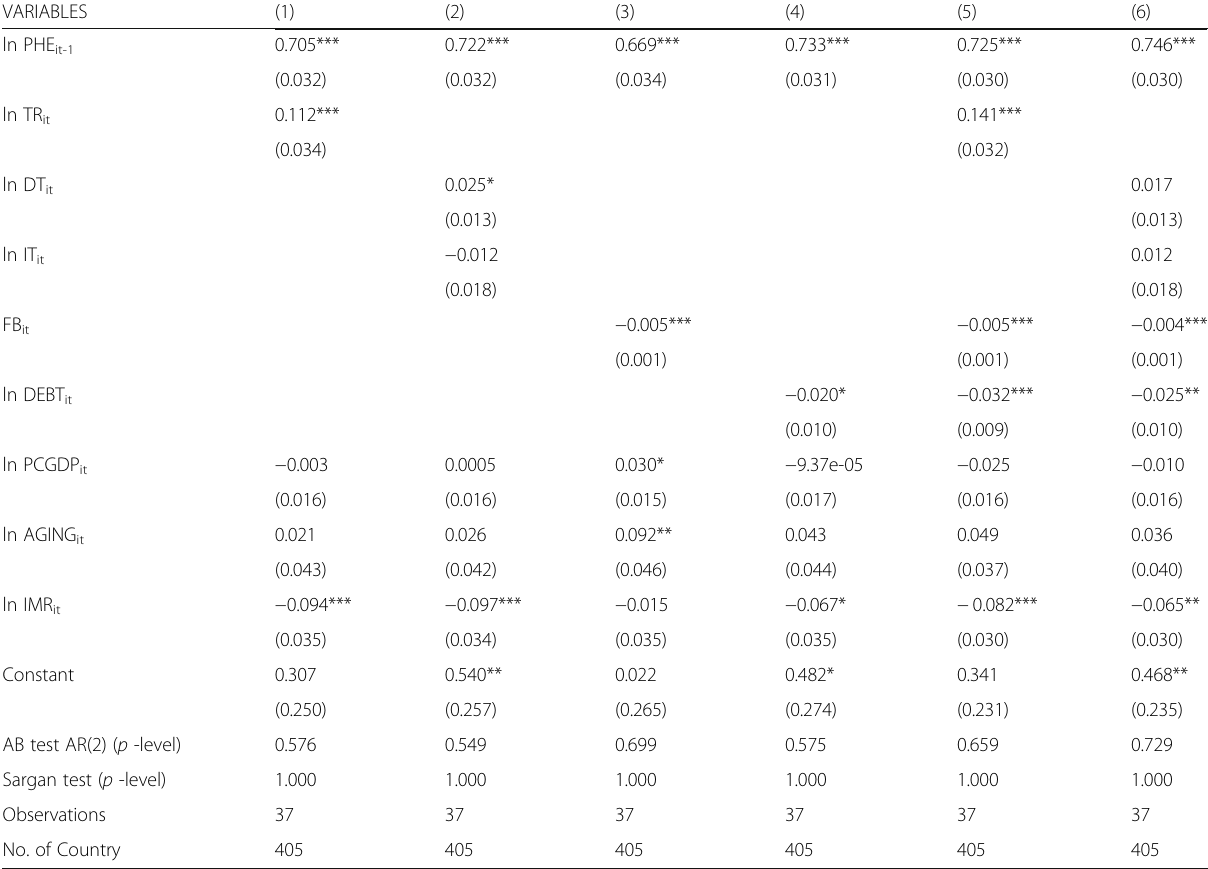
Table 5 Dynamic System GMM Regression Model (Middle Income countries)